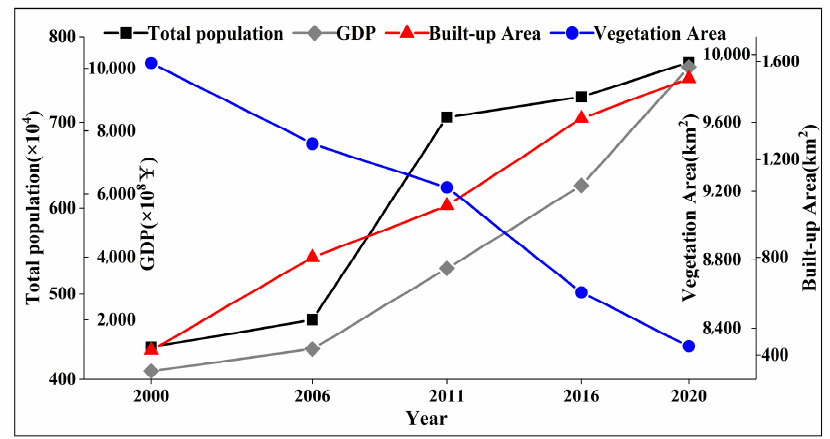
Figure 11. Change chart of four parameters in Hefei area from 2000 to 2020.